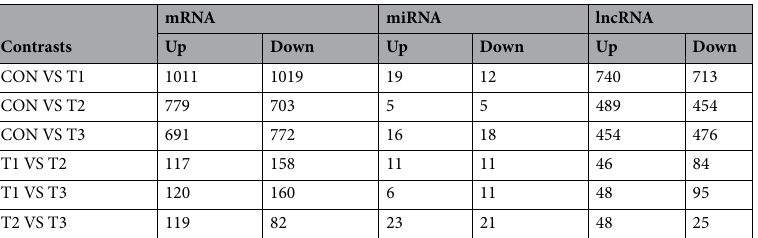
Table 1. Differentially expressed mRNAs, lncRNAs and miRNAs. ZSlg01 and ZSlg02 indicate libraries derived from the lung tissue of Zaosheng cattle in two biological replicates belonging to the CON group. MQlg01, MQlg02, and MQlg03 indicate libraries derived from the lung tissue of yaks living at an altitude of 3,400 m in three biological replicates belonging to the T1 group. LZlg01, BGlg02, and DXlg03 indicate libraries derived from the lung tissue of yaks living at an altitude of 4,200 m in three biological replicates belonging to the T2 group. ADlg01, ADlg02, and ADlg03 indicate libraries derived from the lung tissue of yaks living at an altitude of 5,000 m in three biological replicates belonging to the T3